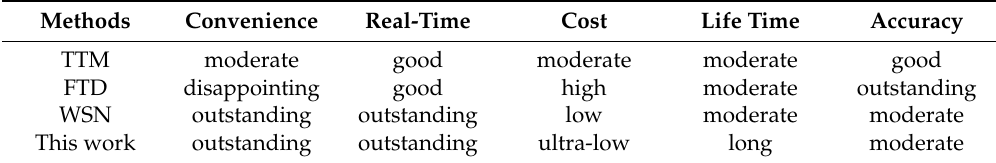
Figure 15. Software interface of the concrete temperature monitoring system. Table 1. Performance comparison of different concrete temperature monitoring methods.